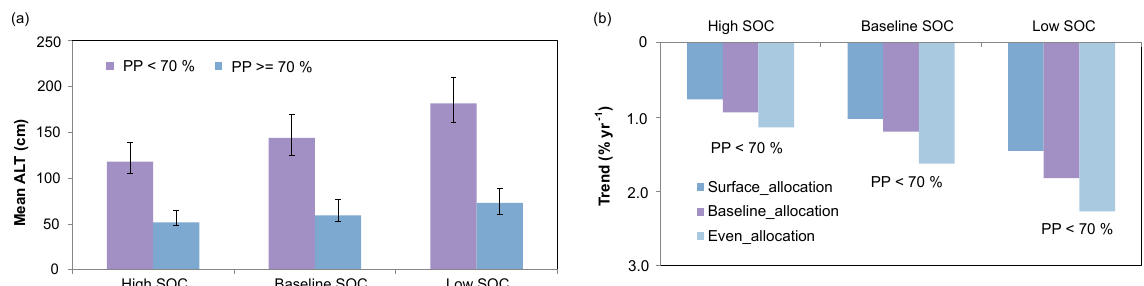
Figure 8. The sensitivity of model-simulated ALT to different SOC levels in two different permafrost probability (PP) zones (Fig. 3b): (a) the model-simulated mean ALT derived for different SOC levels, where error bars represent the variability in model-simulated ALT due to different SOC allocation schemes (i.e., surface or even allocation); (b) shows the trends (%yr − 1 , 2001–2015) in model-simulated areas with ALT < 300cm in the lower-permafrost-probability zone (PP < 70%) in proportion to model simulations in